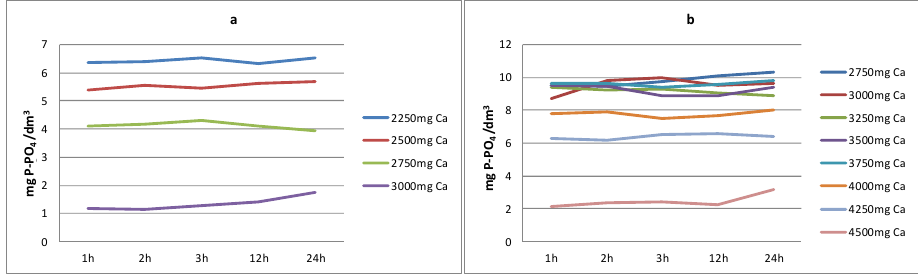
Figure 5. Changes in P-PO 4 concentrations in reject water over time for different doses Ca(OH) 2 for ( a ) WWTP Poznan and ( b ) WWTP Slupsk.